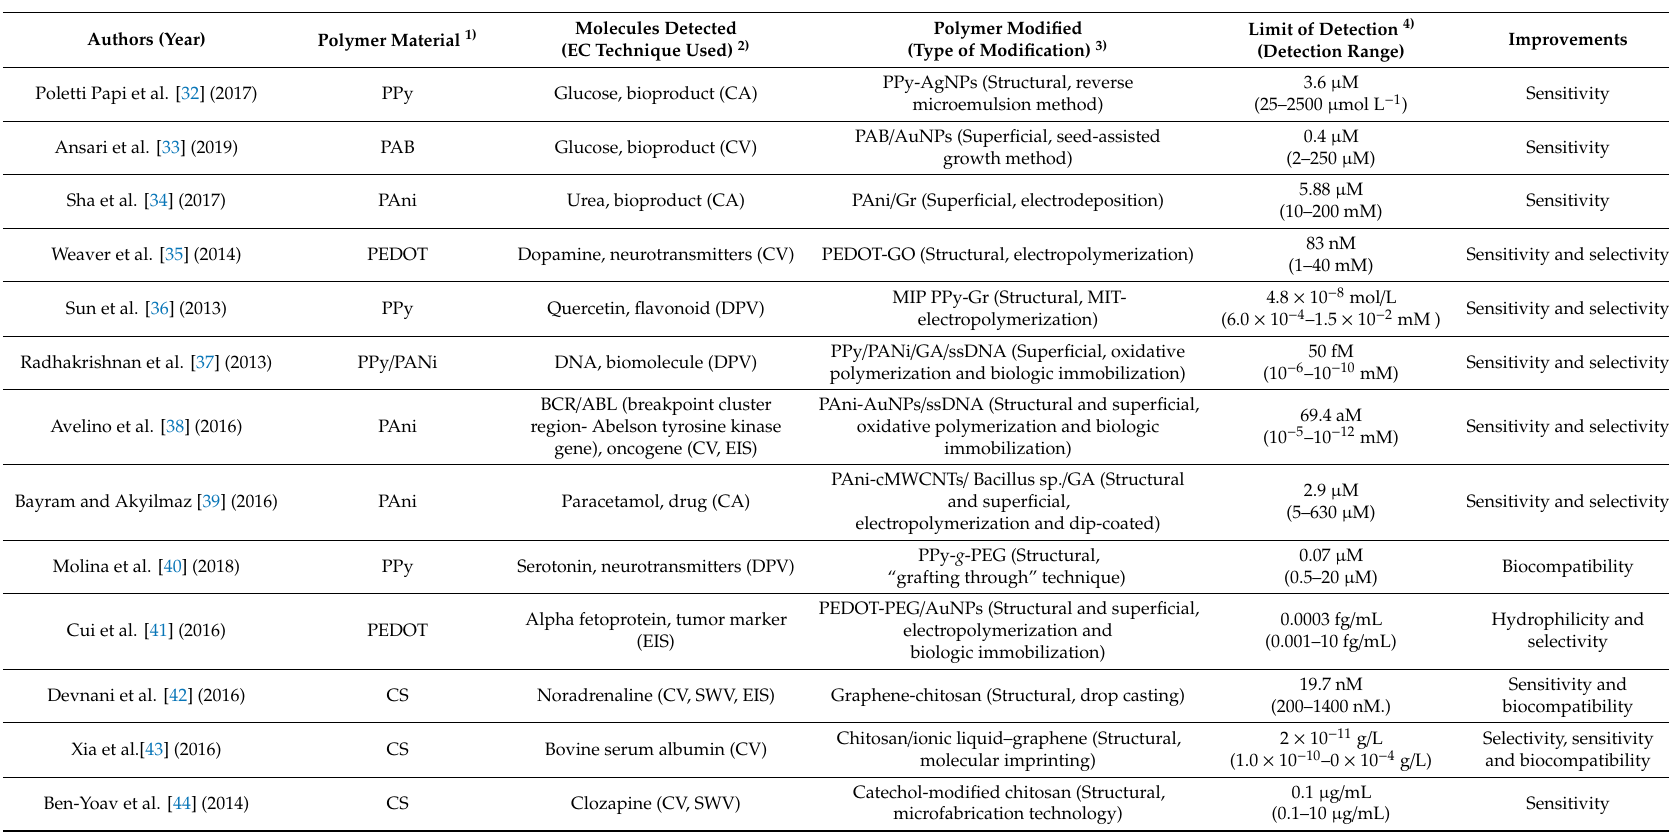
Table 1. Overview of some relevant publications on electrochemical detection based biosensors composed by polymers and on its type of modification, over the past 10